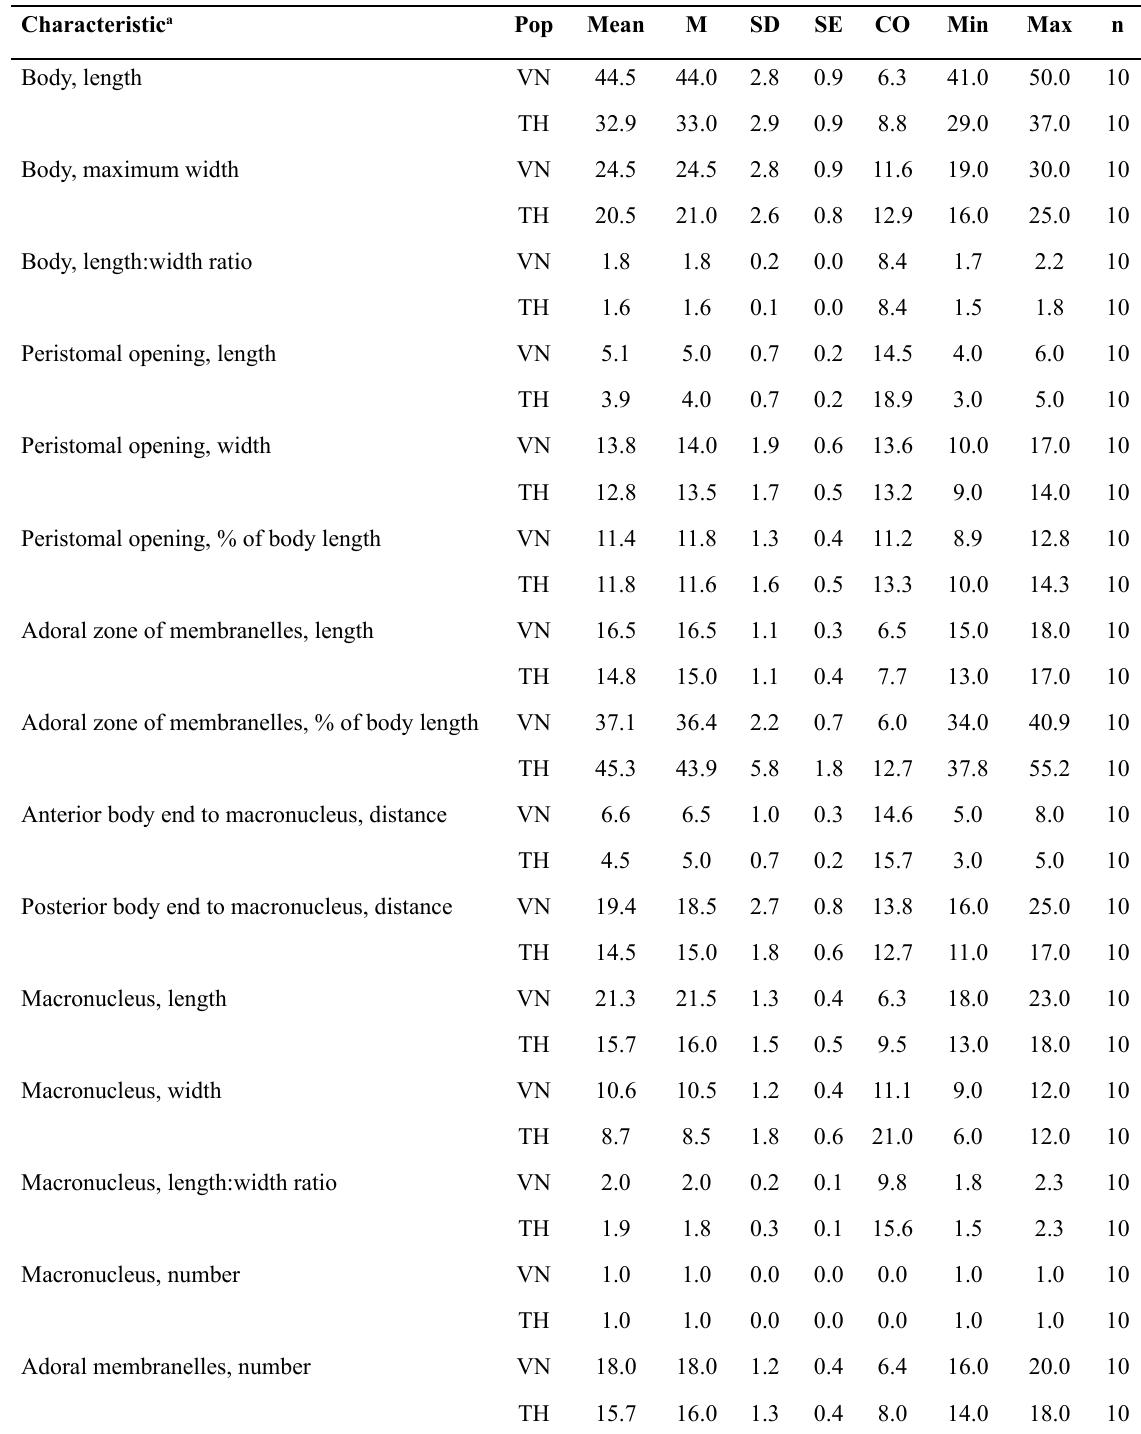
Table 5. Morphometric data on Paraclevelandia brevis Kidder, 1937 from Vietnam and Thailand. Characteristic a Body, length Body, maximum width Body, length:width ratio Peristomal opening, length Peristomal opening, width Peristomal opening, % of body length Adoral zone of membranelles, length Adoral zone of membranelles, % of body